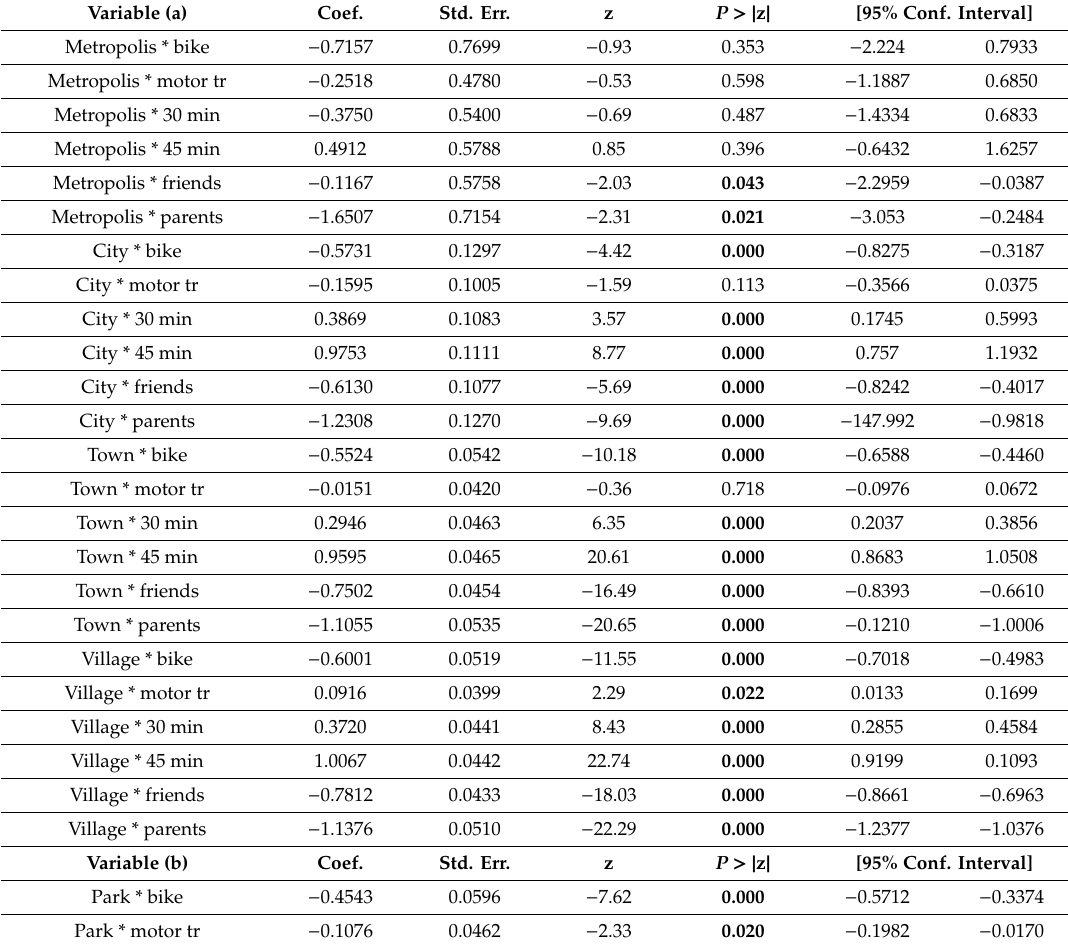
Table A6. Analysis of interaction e ff ects driving adolescents’ preferences: (a) city size / typology where adolescents live; (b) type of